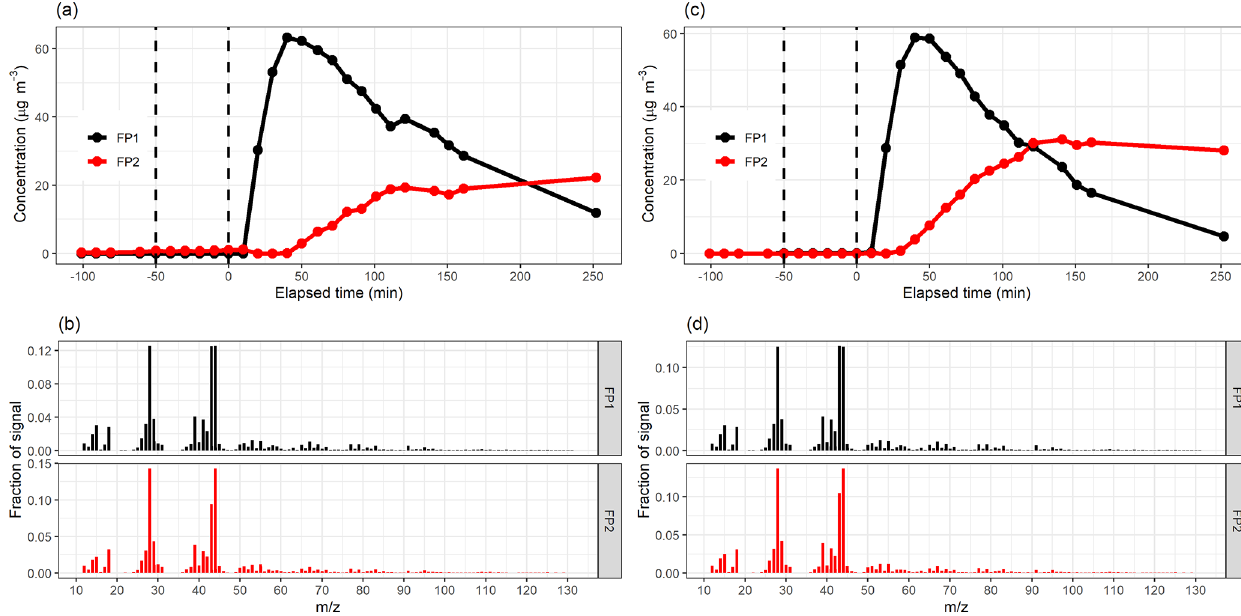
Figure 13. Factor time series and contribution from PMF with static error (a–b) and standard AMS error (c–d) for factorization rank 2 for the measured particle-phase (AMS) data. Factors were identified as SVOOA (FP1) and LVOOA (FP2).